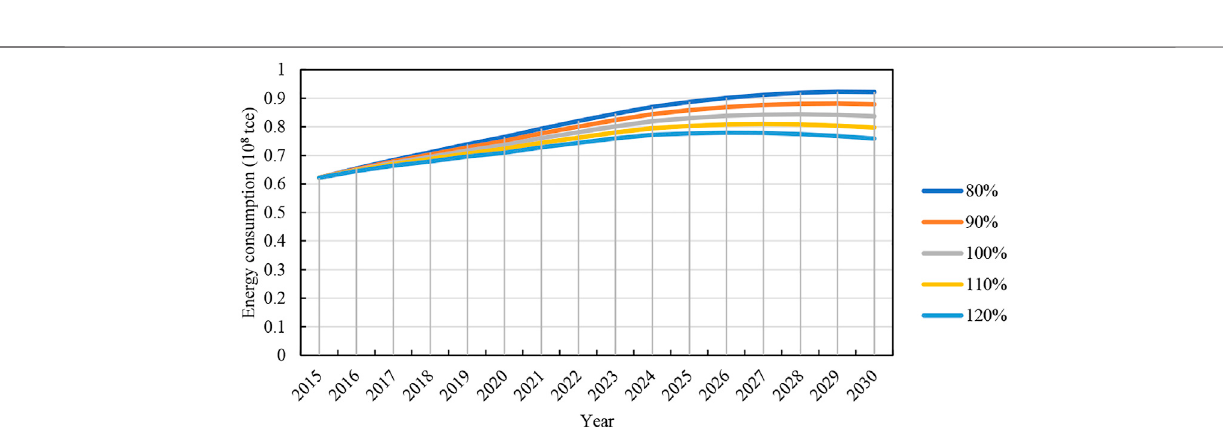
FIGURE 11 | Energy demand under different degrees of implementation of reduction measures in Guangdong